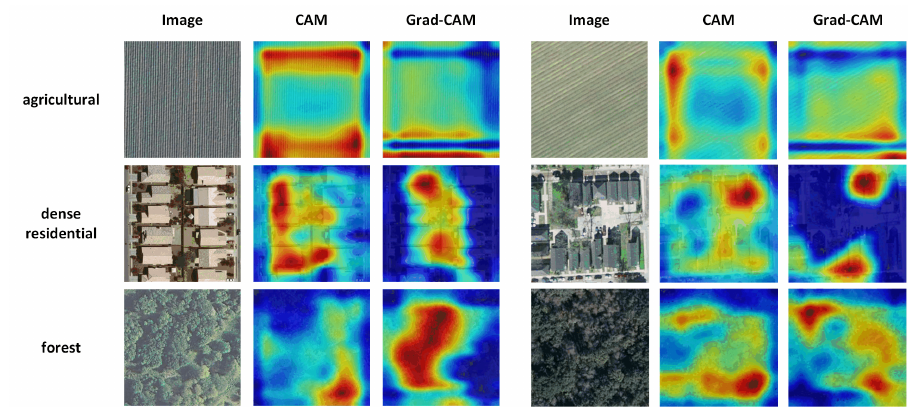
Figure 1. CAM and Grad-CAM on several scenes of remote sensing